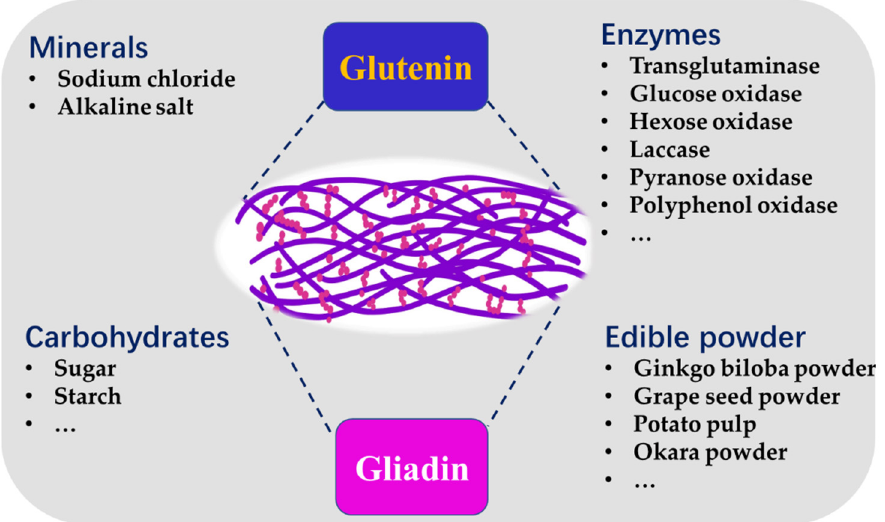
Figure 4. Food components affecting the gluten network of noodles formed by glutenin and gliadin.